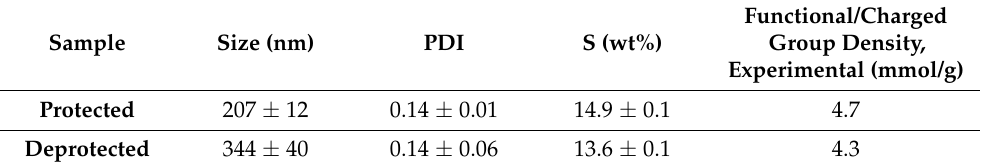
Table 1. Size and related polydispersity index, determined by DLS, as well as sulfur content, analyzed by elemental analysis, of the particles after synthesis (“protected”) and after subsequent deprotection. Mean values and standard deviation were calculated from results of three individual